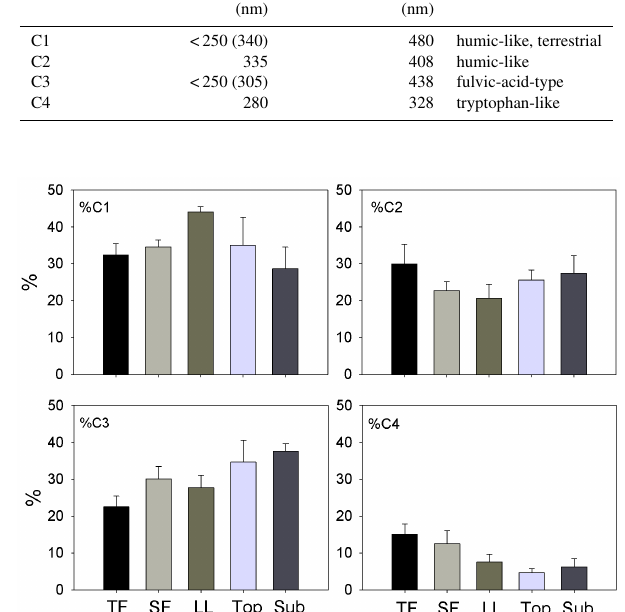
Figure 2. Mean distribution of PARAFAC components %C1–%C4 for different sample